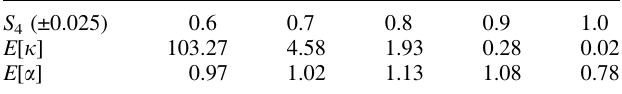
Table 3. E [ a ] and E [ j ] results as functions of S 4 for the tested a - l and j - l models. S 4 (±0.025)